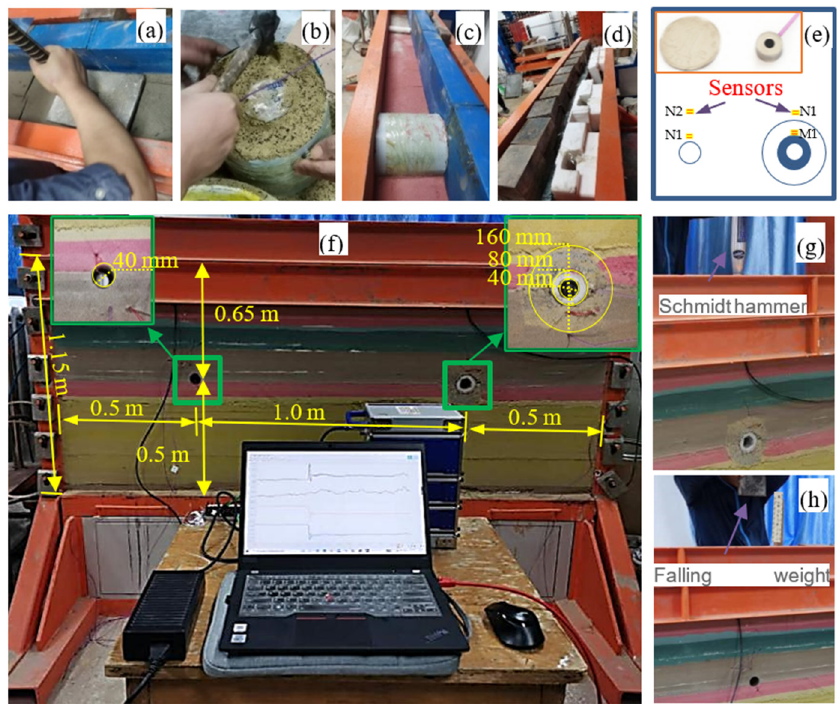
Figure 2. Field of the physical model experiment. ( a – d ) illustrate the building processes of the model included layer-by-layer compaction, construction of the modified roadway, insertion of the roadway models and additional bob-weight loading, respectively, ( e – h ) show the arrangement of the pressure sensors, the experiment field, Schmidt hammer loading and falling weight impact loading, re- spectively.